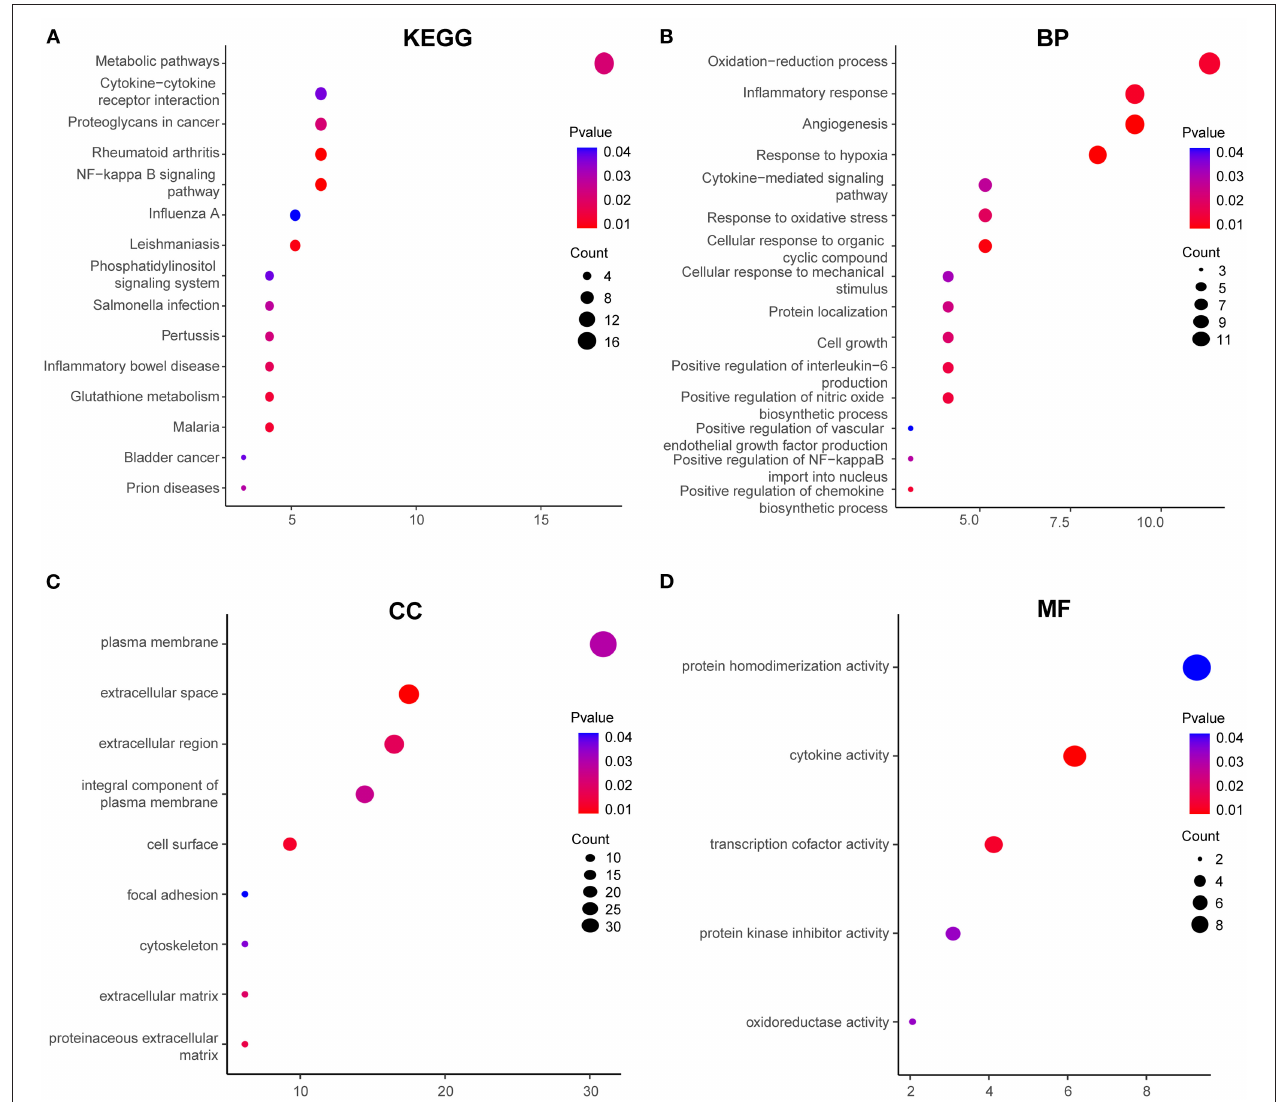
FIGURE 2 | GO functional and KEGG enrichment analyses of 97 DEGs. (A) Significantly enriched KEGG pathways. GO functional enrichment analysis includes biological process (BP) (B) , cellular component (CC) (C) , and molecular function (MF) (D) . Red to blue colors indicate low to high levels of p -value. Point size indicates the number of DEGs in the corresponding